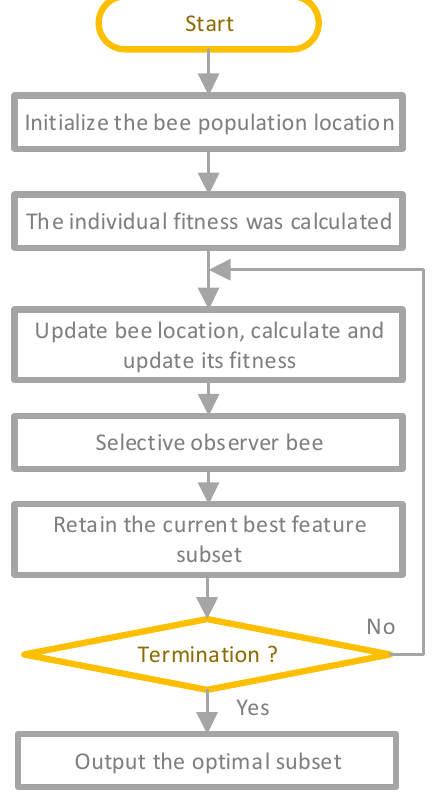
Figure 3. The process of ABC.